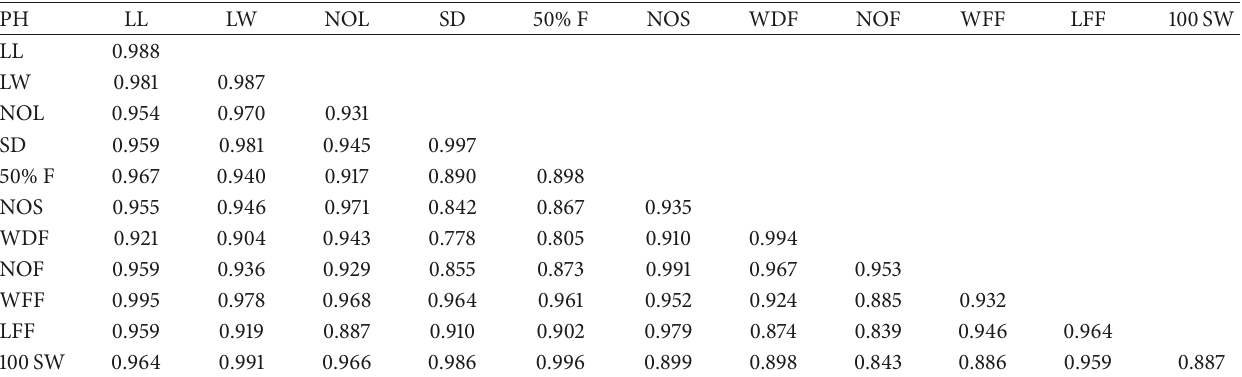
Table 2: Correlations of growth and yield component analysis in